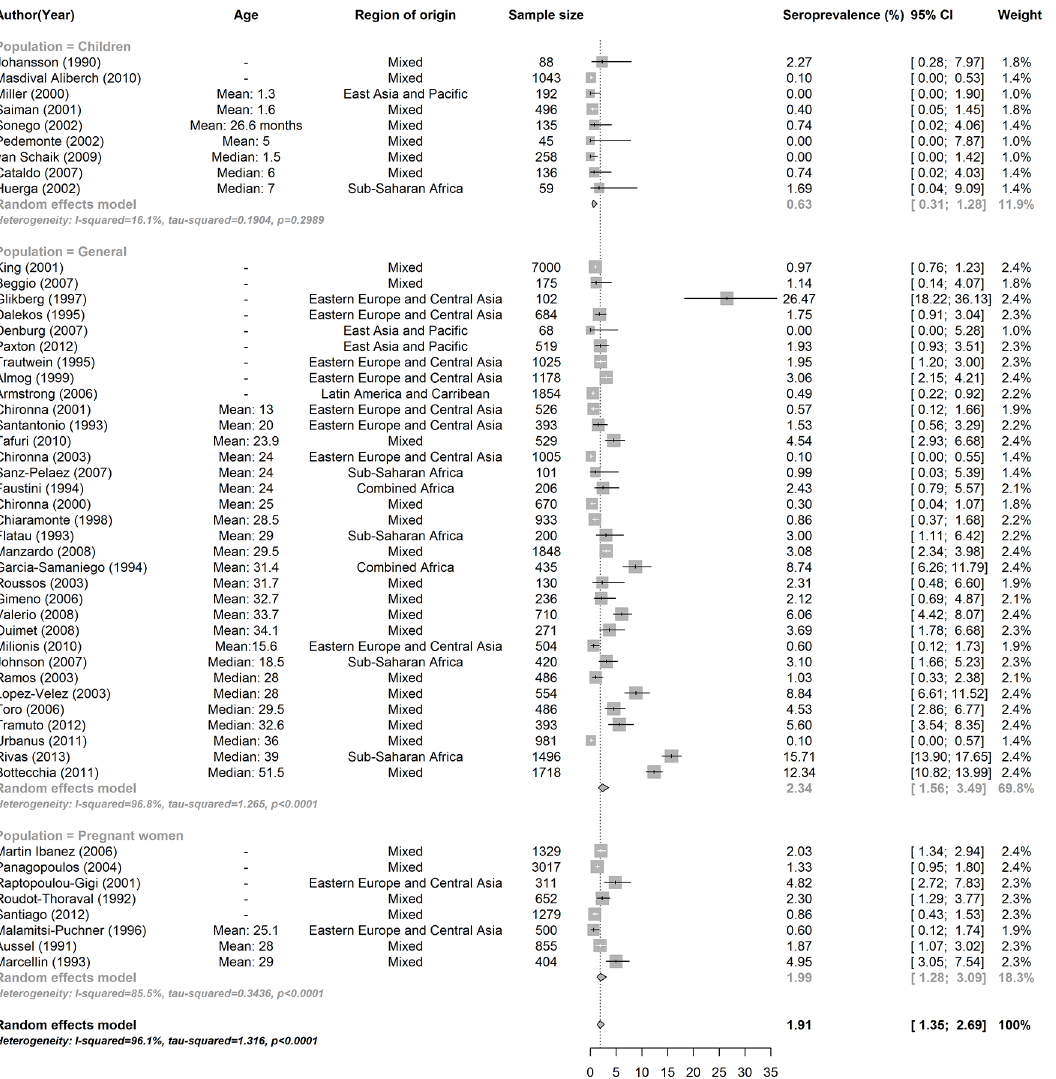
Fig 2. HCV seroprevalence for all included studies stratified by population group and sorted by year of publication (Forest Plot). Regions of Origin: Latin America & Caribbean (LAC), Eastern Europe & Central Asia (ECA), Middle East & North Africa (MENA), Sub-Saharan Africa (SSA), South Asia (SA), East Asia & Pacific (EAP), Mixed (a single study reporting seroprevalence from multiple regions of origin).